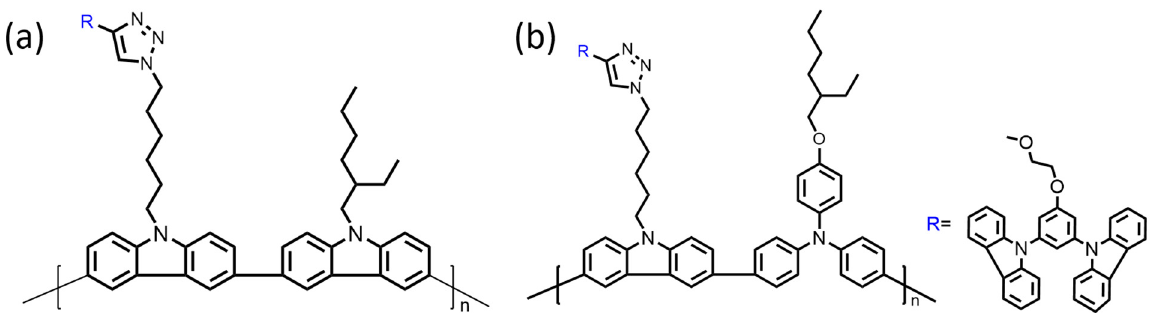
Figure 1. Molecular structures of ( a ) PCz-mCP and ( b ) PTPA-mCP.